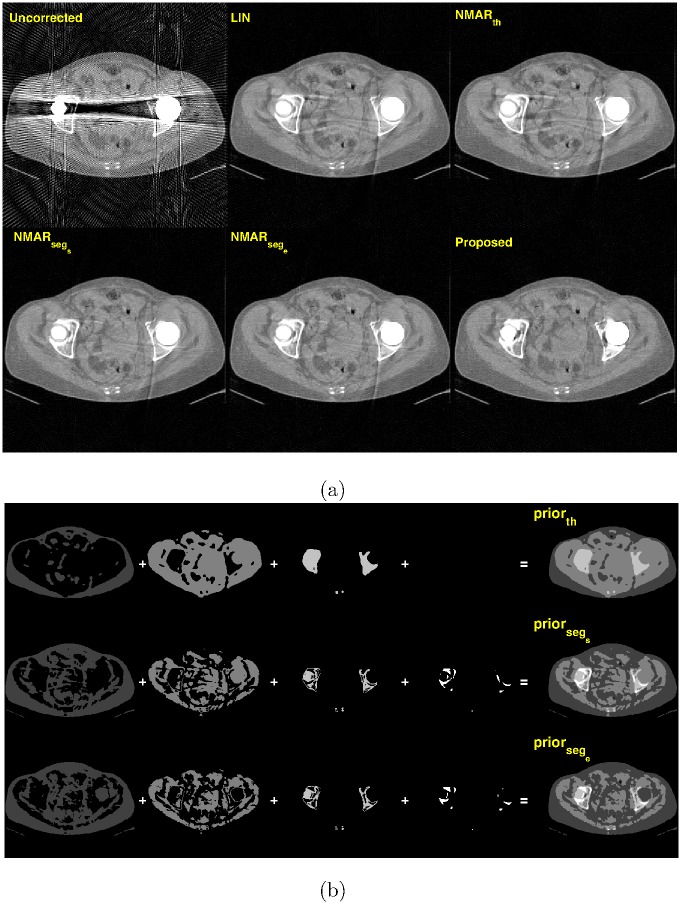
Results of the abdomen phantom (C = 500 HU/W = 1500 HU).(a) Top row: reconstruction images by (left) Uncorrected, (middle) LIN, and (right) NMARth images. Bottom row: reconstruction images by (left) NMARsegs, (middle) NMARsege, and (right) the proposed MAR. (b) Prior images by (top) simple thresholding, (middle) RAC segmentation of the LIN image, and (bottom) RAC segmentation of the final iteration image.